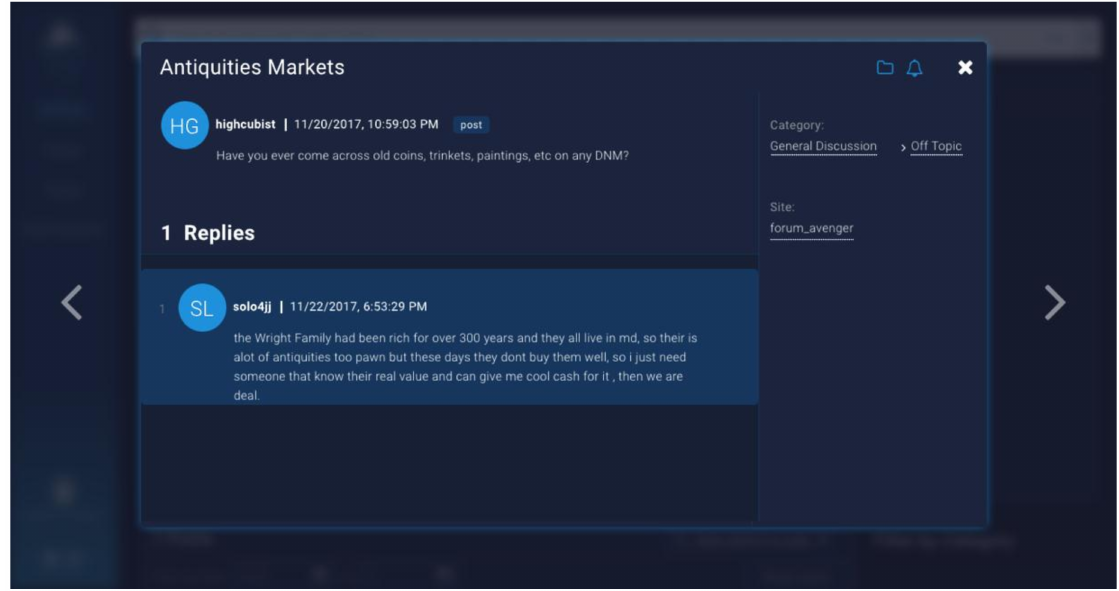
Figure 12. Screen grab of Dark Web forum user highcubist’s inquiry regarding old coins on “DNM” (i.e., Darknet Markets) accessed through the Sixgill cyber intelligence platform. (Screen grab by author